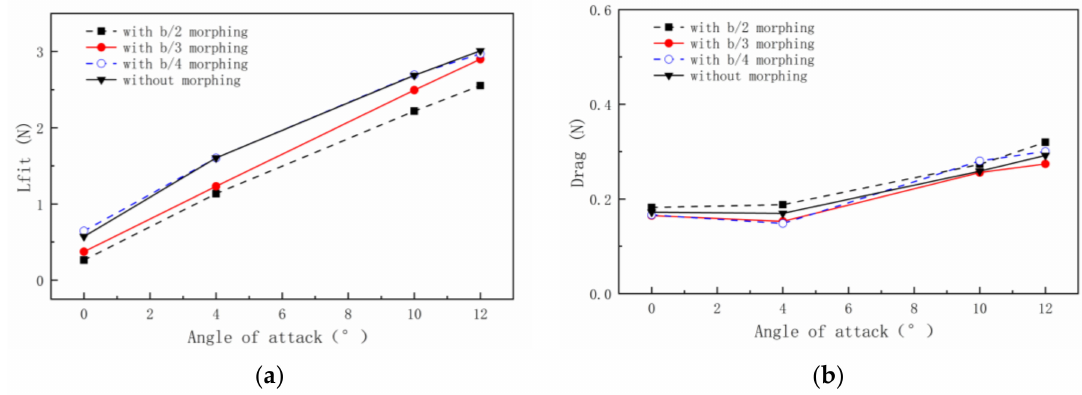
Figure 16. ( a ) Lift force and ( b ) drag force of different wing models at different AOAs.